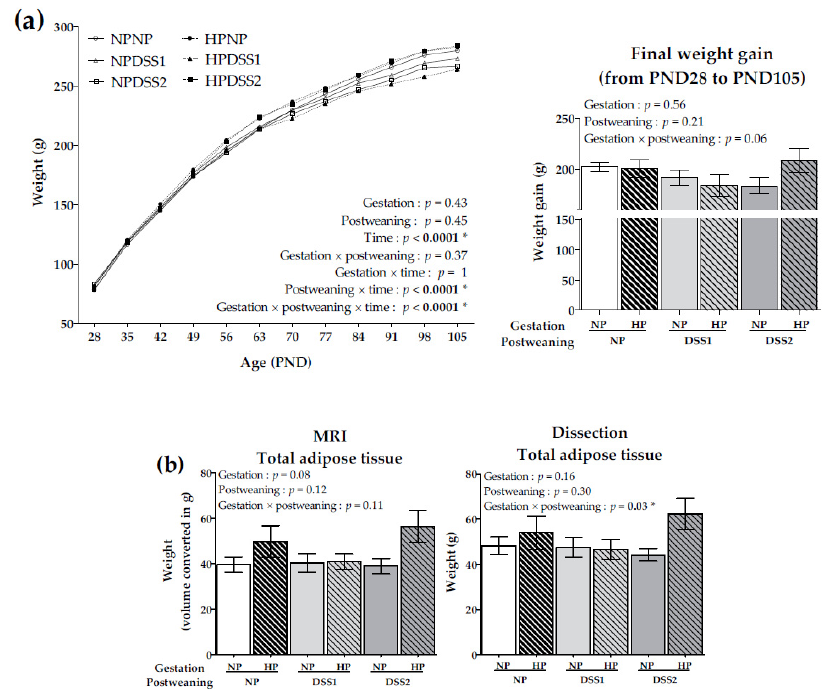
Figure 3. Body weight during the self-selection period from PND28 to PND105 and final weight gain on PND105 ( a ) and total adipose tissue weights on PND105 estimated by Magnetic Resonance Imaging (MRI) and by dissection ( b ). Data are means ± SEMs. Effects of diets were tested within model W and Wt (*, p < 0.05). PND, Post-natal Day; NP, Normal-Protein (control); HP, High-Protein; DSS1, Dietary Self-Selection 1 (P and G/L in 2 different cups); DSS2, Dietary Self-Selection 2 (P, G and L in 3 different cups); MRI: Magnetic Resonance Imaging.